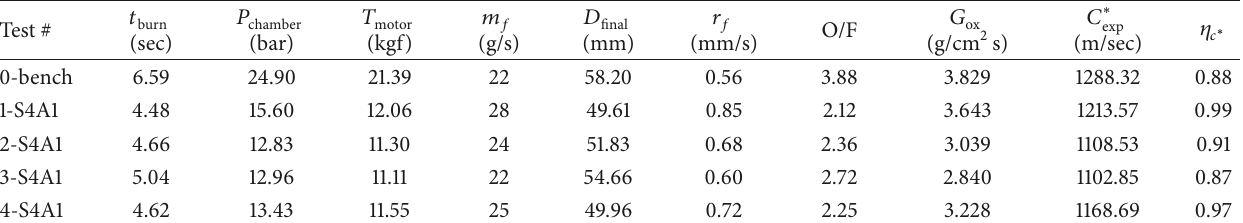
Table 6: Ballistic characteristics of tests.